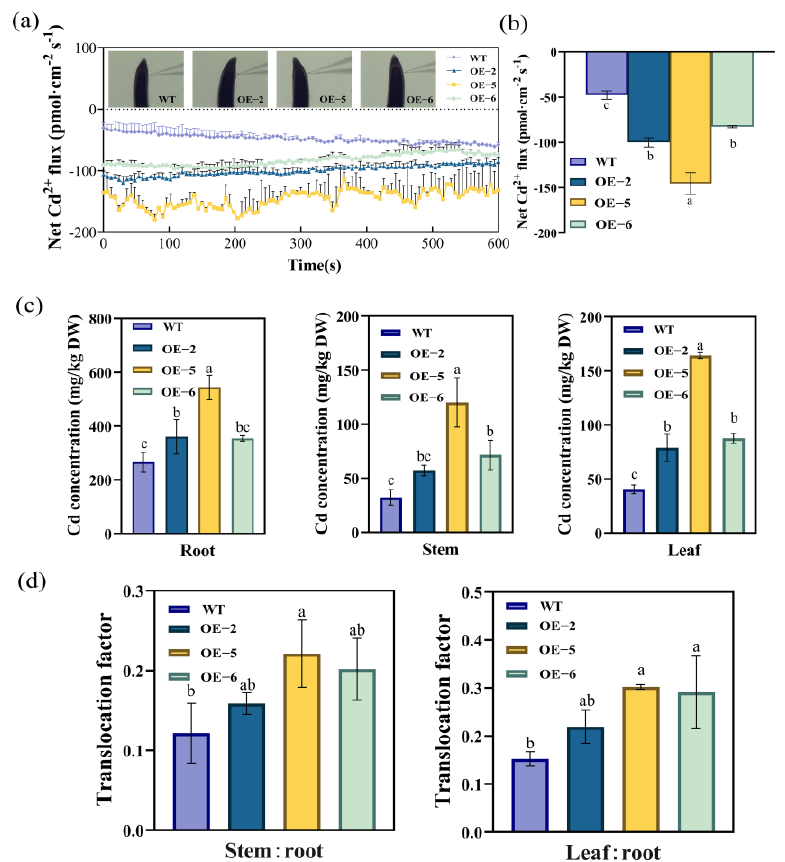
Figure 2. The net Cd 2+ influxes and Cd concentration. ( a ) Net Cd 2+ influx in transgenic poplars and WT in 400 μm from the root tips for 600 s; ( b ) mean Cd 2+ fluxes in root tip cells within 600 s; ( c ) Cd concentration in roots, stems and leaves of transgenic poplars and WT under Cd stress; ( d ) translocation factors (TFs) to Cd of SpHsfA4c -transgenic poplars and WT under Cd stress for 30 d. Data are presented as means ± SD. Different letters above the bars represent significant differences at p <